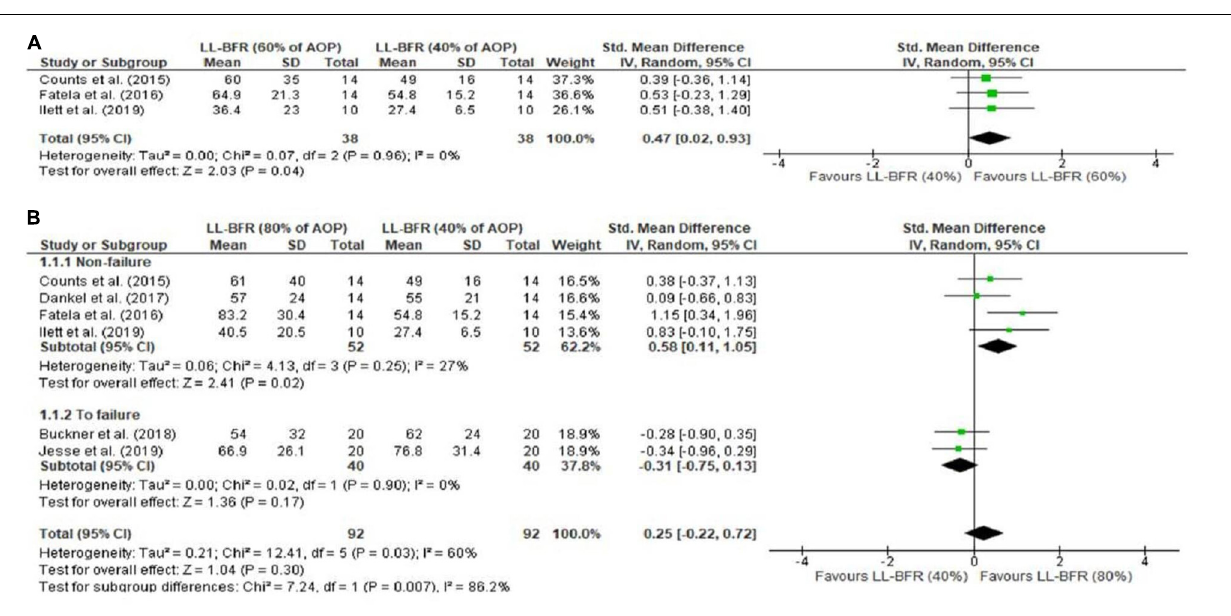
FIGURE 4 | Forest plot illustrating the combined effects for myoelectric activity of: (A) LL-RE with BFR pressure of 40% AOP vs. LL-RE with BFR pressure of 60% AOP; (B) LL-RE with BFR pressure of 40 AOP vs. LL-RE with BFR pressure of 80% AOP. 95%CI: confidence interval; AOP: arterial occlusion pressure; LL-BFR: low load + blood flow restriction; LL: low load; SD: standard